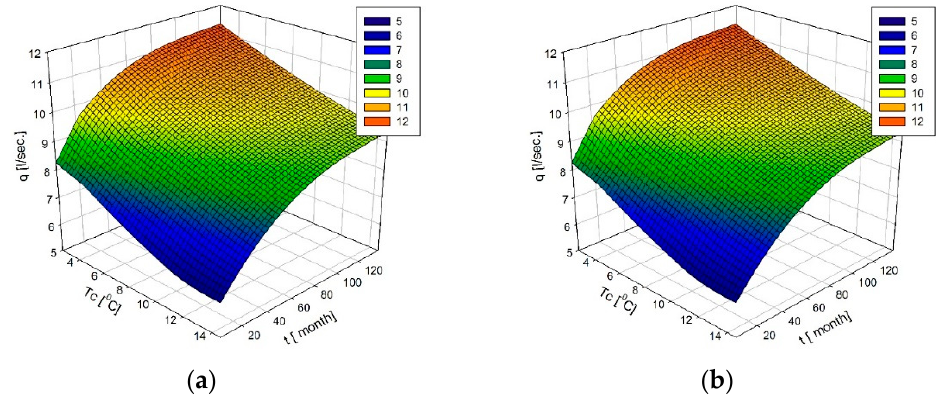
Figure 7. Model of HT total water loss: examples ( a ) q = f(Tc, t) and ( b ) q = f(Tc, Hst).